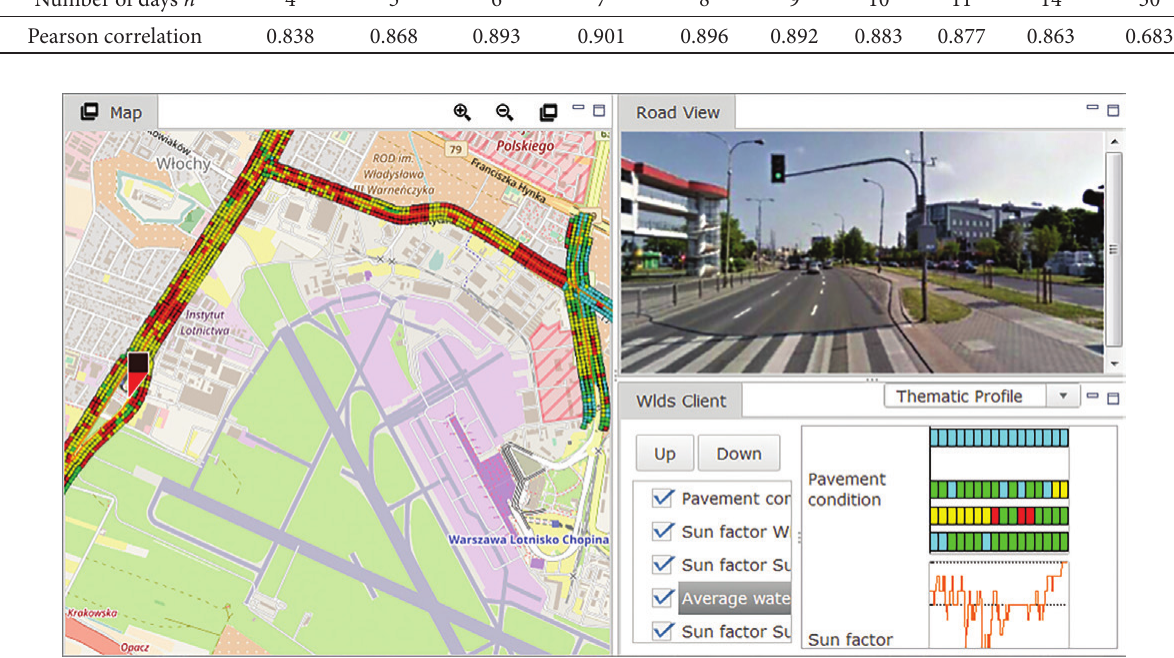
Fig. 5. The localization of the road weather station shown in a screenshot from an online road data provision system